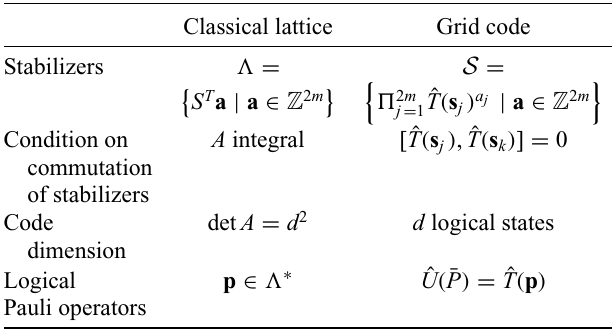
TABLE II. Expression of different QEC concepts for lattices in R 2 m and grid codes in m modes. Classical lattice Grid